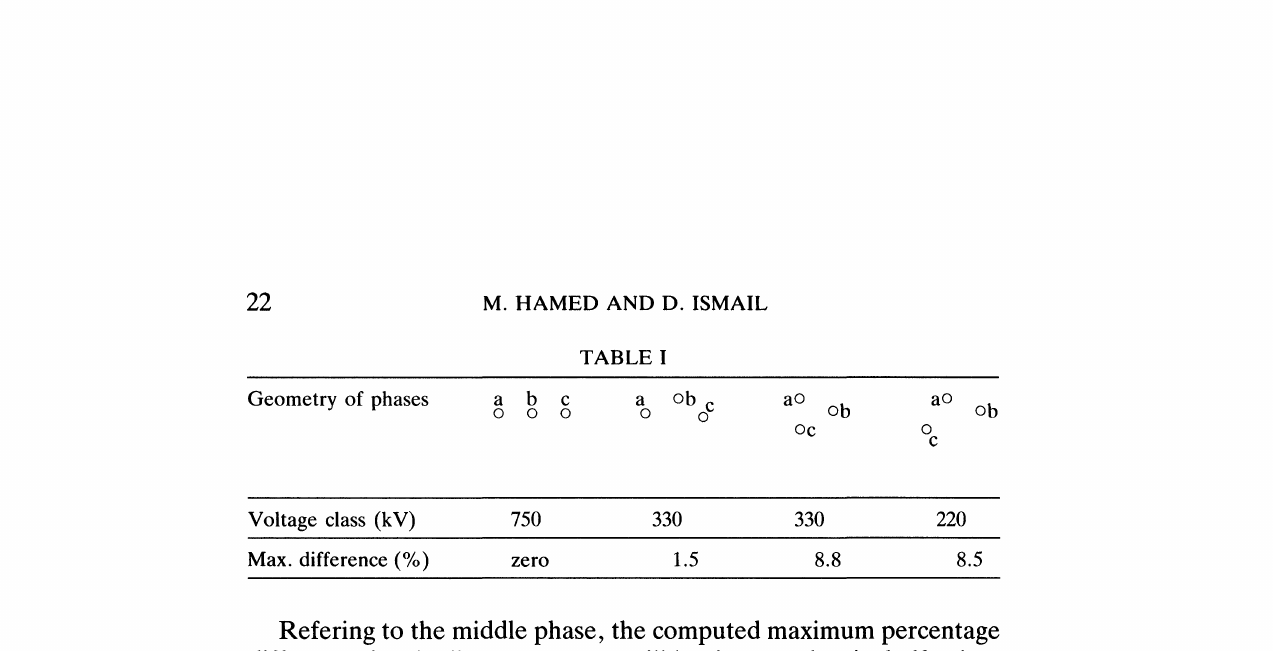
Geometry of phases a b